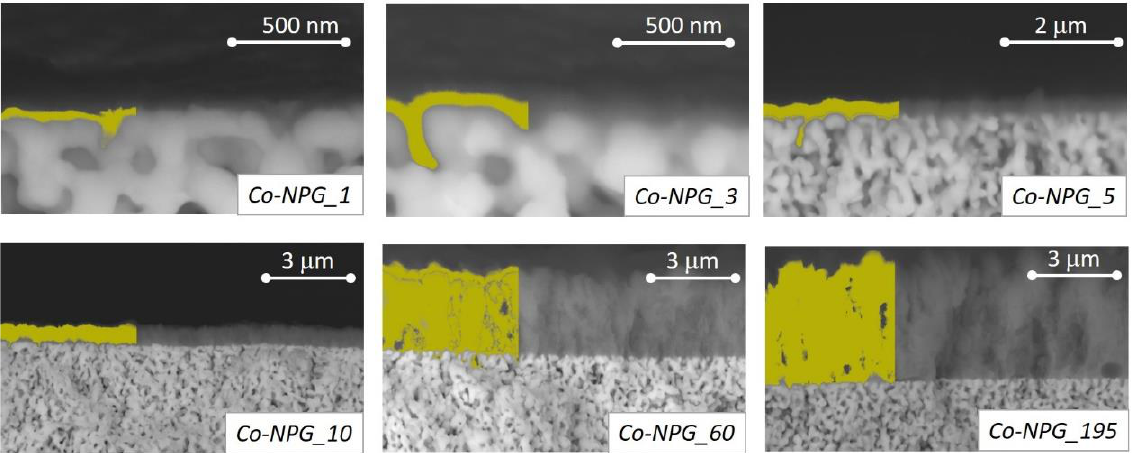
Figure 4. BSE-SEM cross-section images of the morphology of all studied hybrid Co/NPG heterostructures. The images are taken using backscattered electrons. The yellow color is used to emphasize the Co layer.